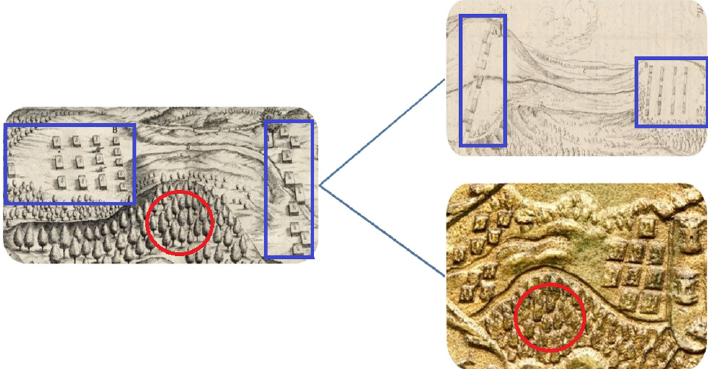
Fig. 7. The juxtaposition of the drawing (National Archives in the Hague, Dutch West India Company, 51, No. 65, p. 14) and the medal with a print depicting the battle between Camarigibi and Porto